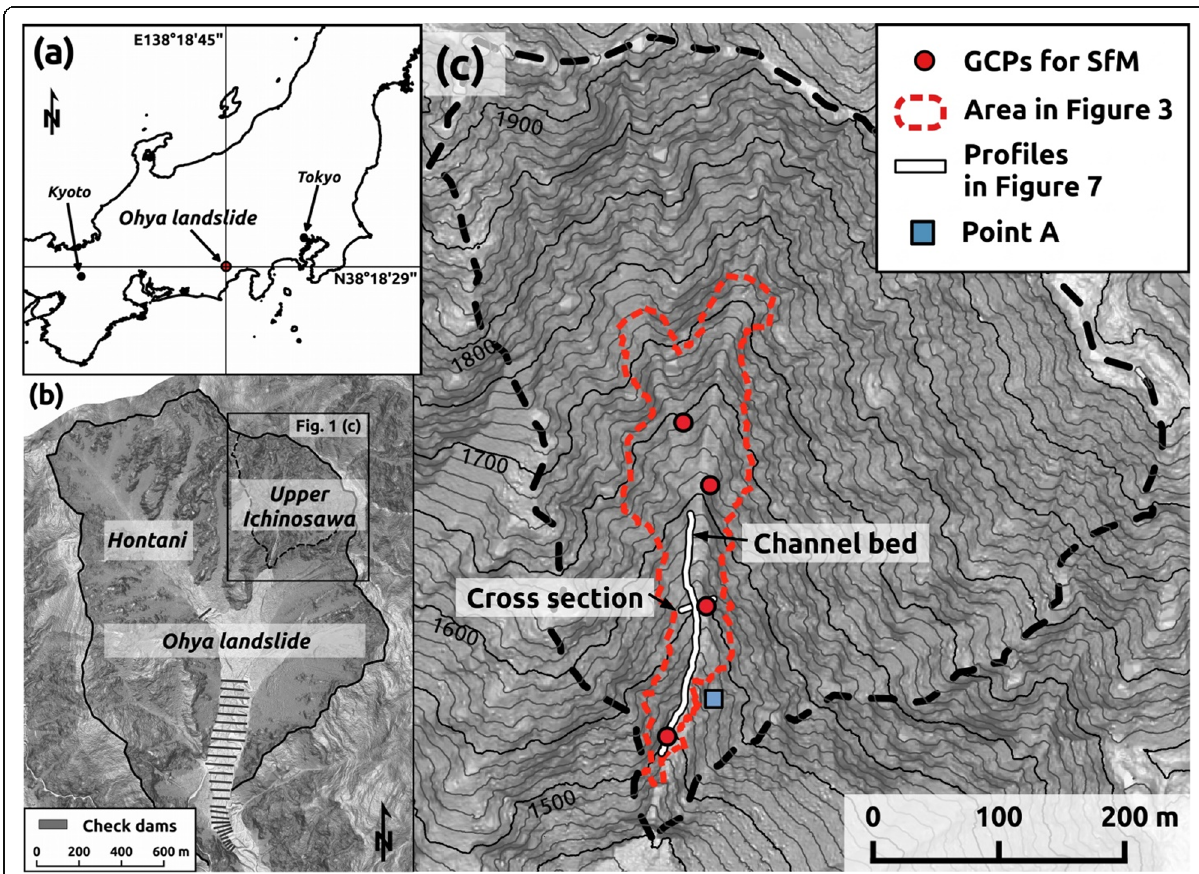
Fig. 1 Study site. a Overview. b The Ohya landslide. c The upper Ichinosawa